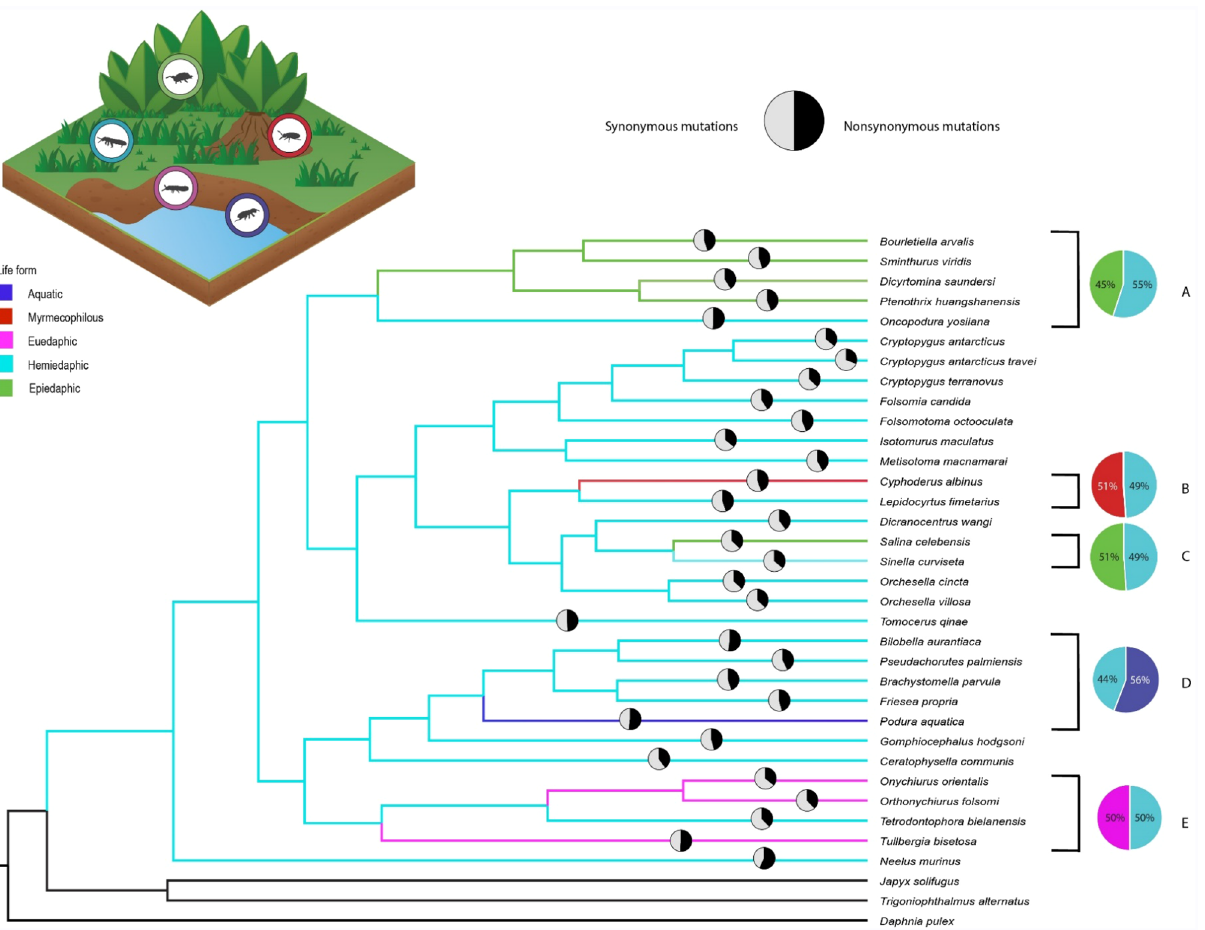
Figure 1. Bayesian phylogenetic tree based on the mitogenomes of 32 collembolan species from four orders and three outgroup taxa indicating the evolution of life form traits for each species (blue: aquatic; red: myrmecophilous; pink: euedaphic; cyan: hemiedaphic, and green: epiedaphic). The pie charts along the terminal branches represent the number of nonsynonymous (black segments) and synonymous (grey segments) mutations. The coloured pie charts represent the proportion of nonsynonymous mutations (i.e. dN/(dN + dS)) for the branches/clades that represent the evolution of an alternative life form (blue: aquatic; red: myrmecophilous; pink: euedaphic, and green: epiedaphic) vs. the sister branches/taxa that represents the ancestral state (cyan: hemiedaphic). Where multiple branches are present (i.e. clades), we accounted for the number of taxa by averaging the proportion of mutations for each terminal and internal